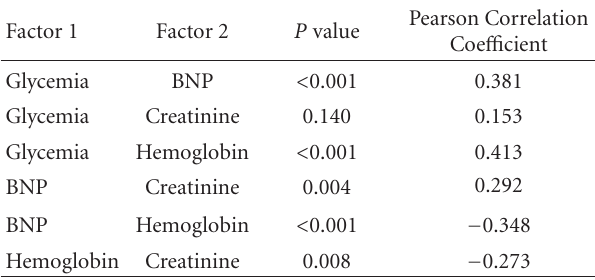
Figure 2: Adjusted two-year event-free survival, according to BNP < or ≥ 300 pg/mL. Table 4: Correlations between blood glucose, BNP, hemoglobin, and